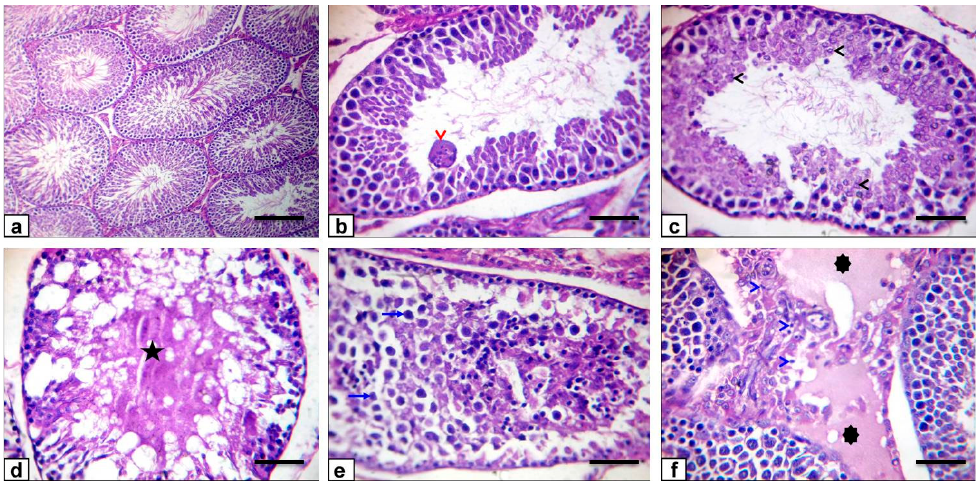
Figure 9. Photomicrograph of rat testes stained with HE: ( a ) BZnO-1 rats showing a normal histoarchitecture of the seminiferous tubules (scale bar = 100 µ m). ( b – f ) BZnO-2 rats showing multi-nucleated giant cell formation in the lumen of some seminiferous tubules (red arrowhead), with fragmentation and necrosis of the germinal epithelium (black arrowheads); this besides necrotic seminiferous tubules, depletion of germinal cells and hyalinization of the luminal contents (star), sloughing of the germinal epithelium in the lumen of seminiferous tubules (blue arrows), and interstitial edema (asterisks), with mild inflammatory cell infiltration (blue arrowheads) (scale bars = 50 µ